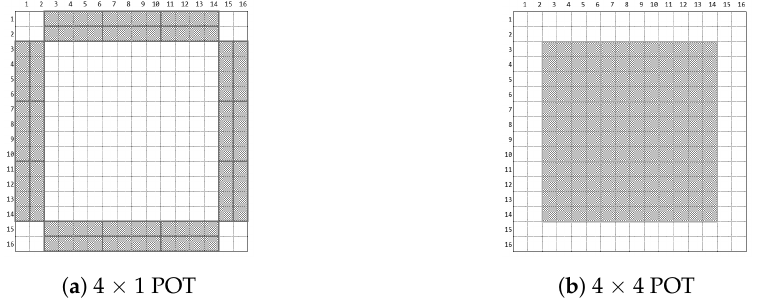
Figure 9. Two different types of POT application areas represented in grey.